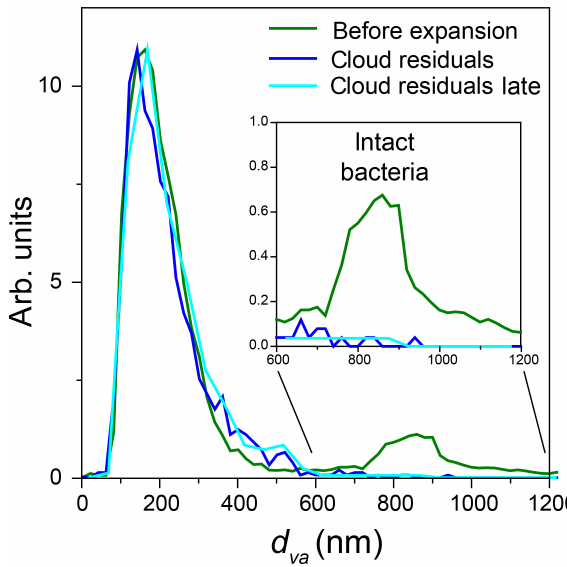
Figure 14. d va size distribution, measured by miniSPLAT before Expansion 3 (green) with PF CGina bacteria, of cloud residuals (blue) and of cloud residuals measured during the later part of the expansion (302–557s) when the number concentration of sampled droplets and ice crystals was nearly the same (light blue). The inset shows an expanded scale of the region of intact